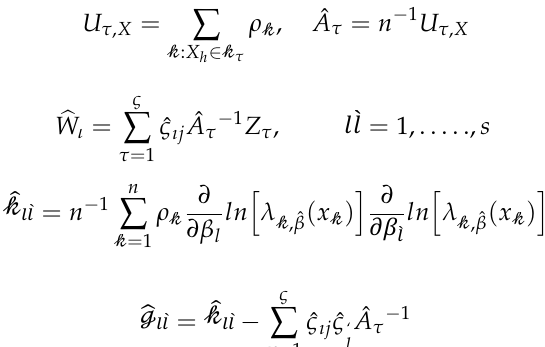
Table 11. Simulation results for the empirical levels versus the corresponding theoretical levels for 𝜀 = 1%; 2%; 5%; 10% and 𝑁 = 12,000 .